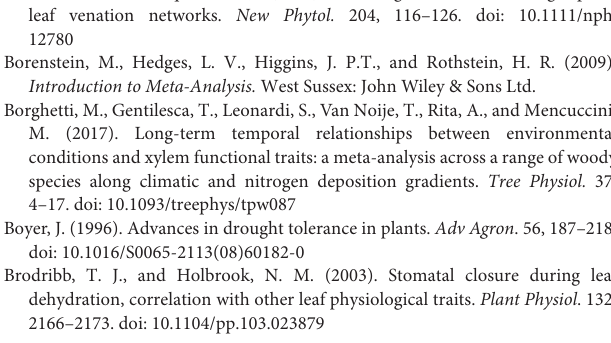
Table S1 | Summary of the heterogeneity between moderator levels (Qb) (plant taxonomic groups, fertilizer types, N-addition levels and treatment durations) and P -value. Table S2 | The percentage change (%) caused by N addition for each variable and the variables are categorized into different groups according to climate type and N2-fixing or non-N2-fixing